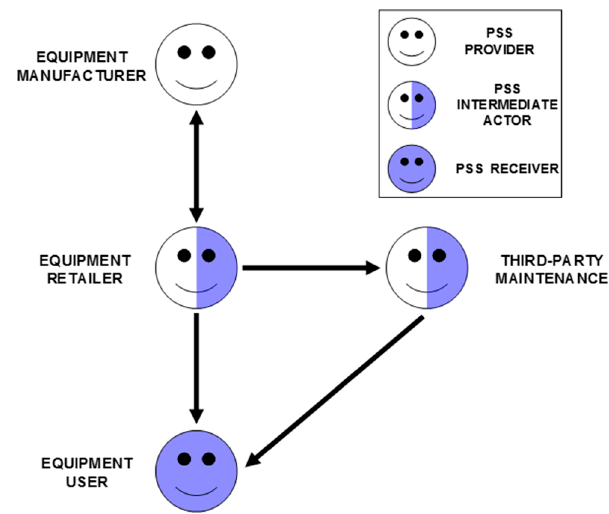
Figure 2. The PSS view model (adapted from reference [24]).